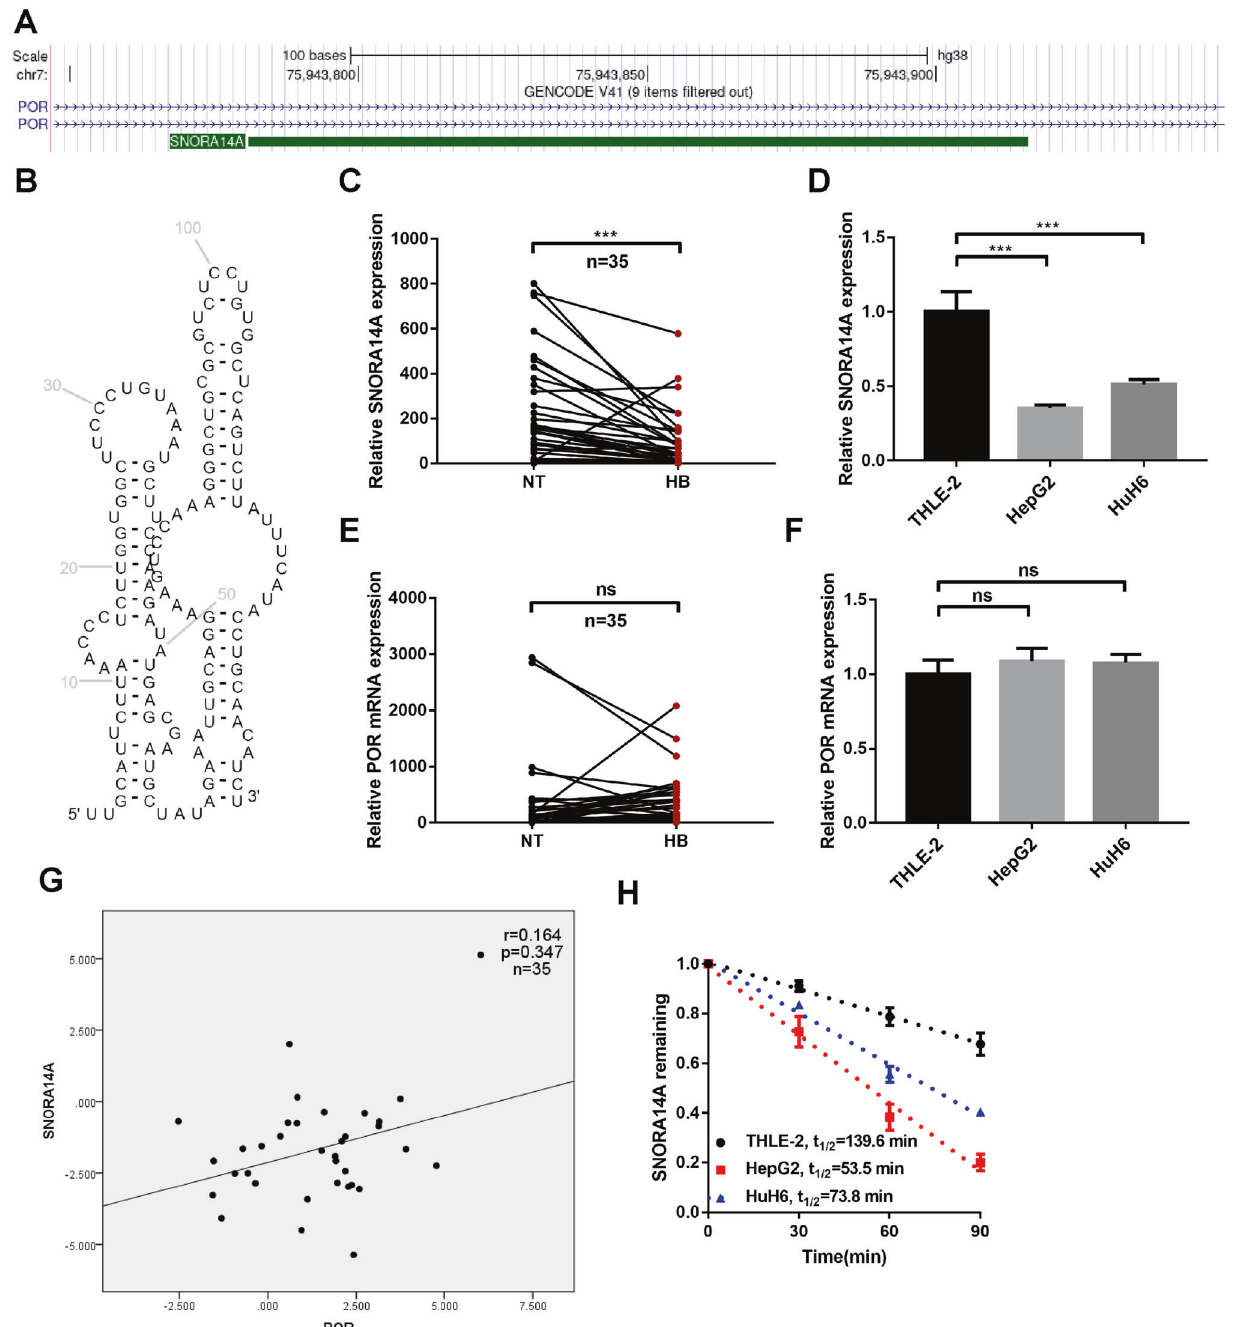
Fig. 2 Signi fi cant downregulation of SNORA14A in HB tissues and cells. A The location of SNORA14A and POR from the UCSC Genome Browser. B The secondary structure of SNORA14A. C – F Relative expression levels of SNORA14A ( C ) and POR ( E ) in 35 pairs of HB and NT tissues were measured by qRT ‒ PCR. The relative expression levels of SNORA14A ( D ) and POR ( F ) in THLE-2, HepG2 and HuH6 cells were measured by qRT ‒ PCR. G Spearman rank correlation analysis of SNORA14A and POR expression levels. H SNORA14A levels in THLE-2, HepG2 and HuH6 cells were measured using qRT ‒ PCR after treatment with 5 μ g/ml actinomycin D for the indicated times. cytochrome P450 oxidoreductase gene POR (Fig. 2A). SNORA14A differentially expressed snoRNAs con fi rmed that posttranscrip- is 135 nt long and contains two highly conserved sequence tional regulation of gene expression, regulation of translation, and elements, the H box (ATAGAA) and the ACA box (ACA) (Fig. 2B). the mRNA metabolic process were enriched, suggesting that qRT ‒ PCR was performed to determine SNORA14A expression in 35 snoRNAs derived from these host genes might be involved in paired HB tissues and adjacent NT tissues. We found that these biological processes (Fig. 1D). Then, we selected SNORA14A, SNORA14A expression was markedly decreased in HB tissues which ranked fi rst among 64 signi fi cantly downregulated snoRNAs compared to NT tissues (Fig. 2C). Consistently, SNORA14A according to the log2-fold change (log2 FC = − 2.522), for further expression in two HB cell lines (HepG2 and HuH6) was apparently study. SNORA14A is generated from the fi rst intron of the